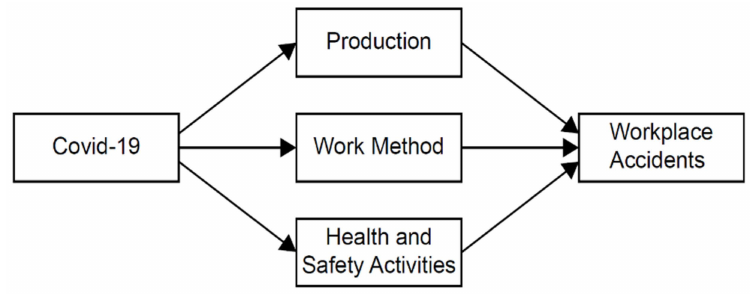
Figure 1. Pathways between COVID-19 and workplace